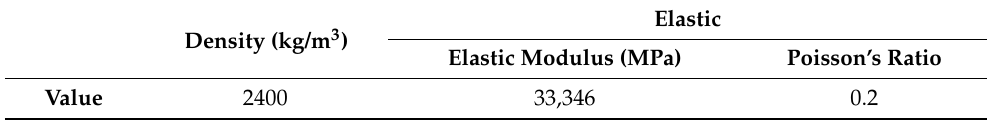
Table 5. Concrete material properties.